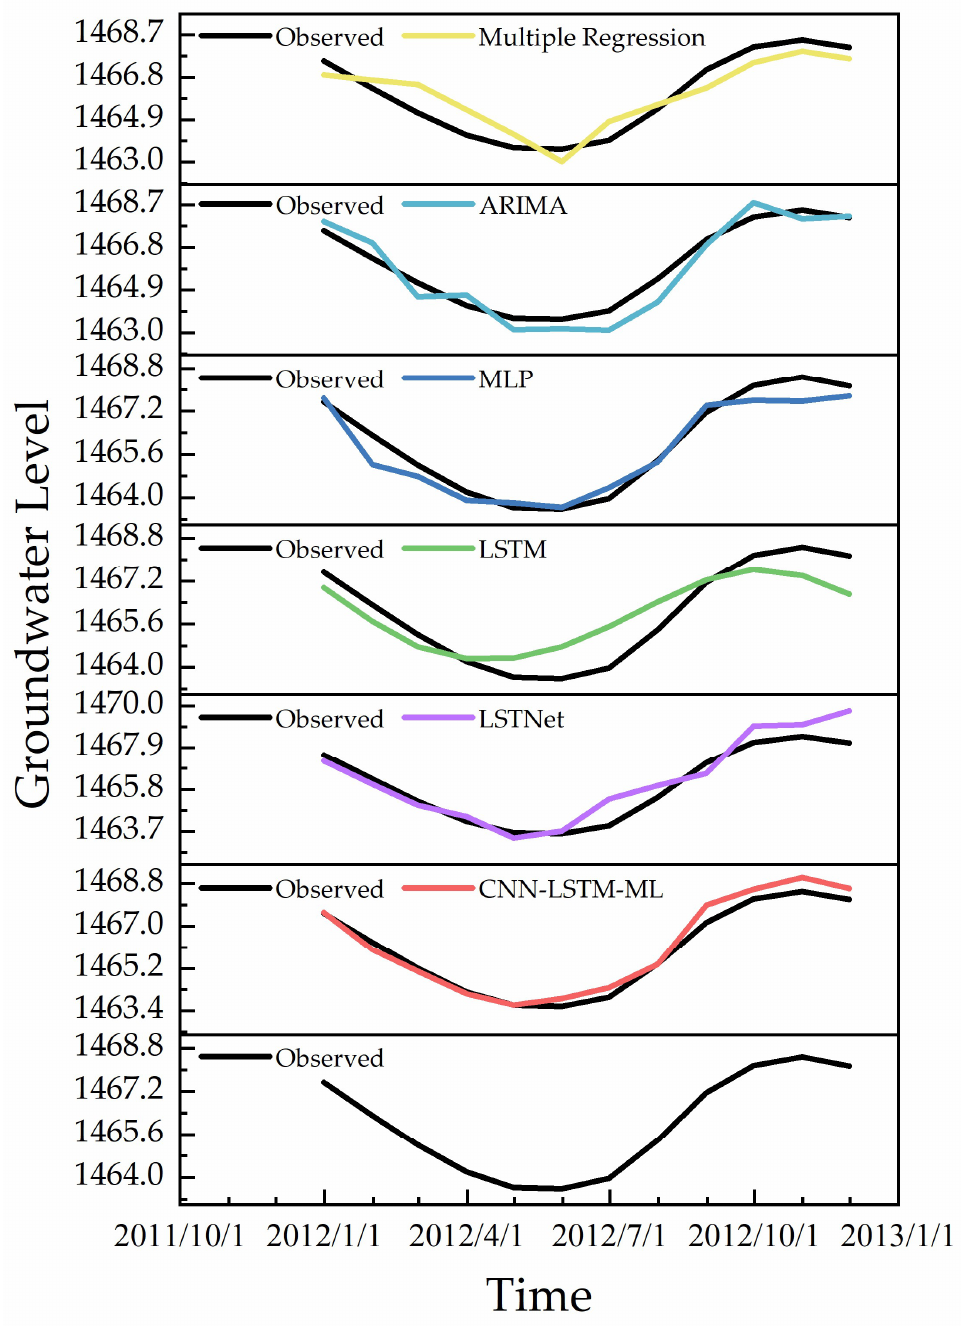
Figure 8. The prediction effect of the model on the data of an observation well.